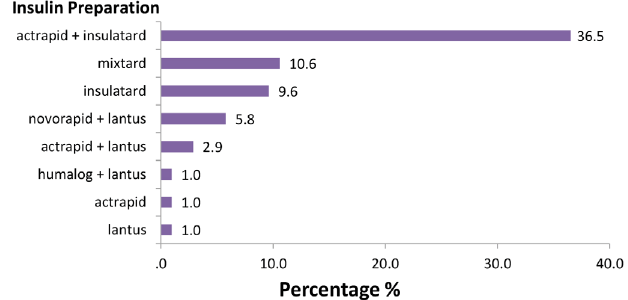
FIGURE 6 - Dosing agents for alpha-glucosidase, DPP4 and Thiazolidinediones; BD, twice daily; OD, once daily; TDS, three times daily.